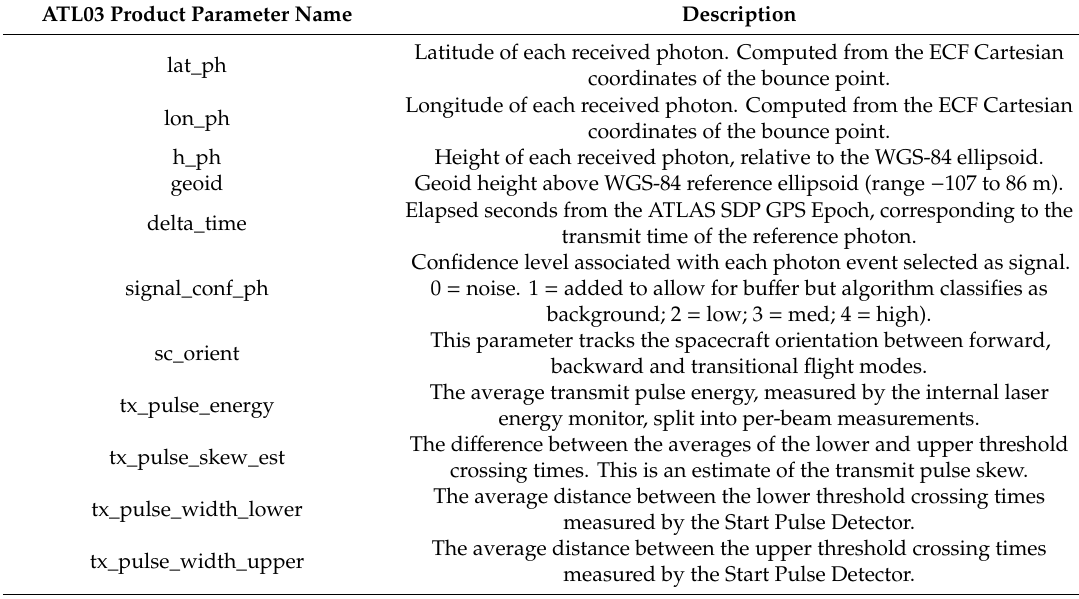
Table 1. The statistical indicators of global geolocated photon (ATL03) data